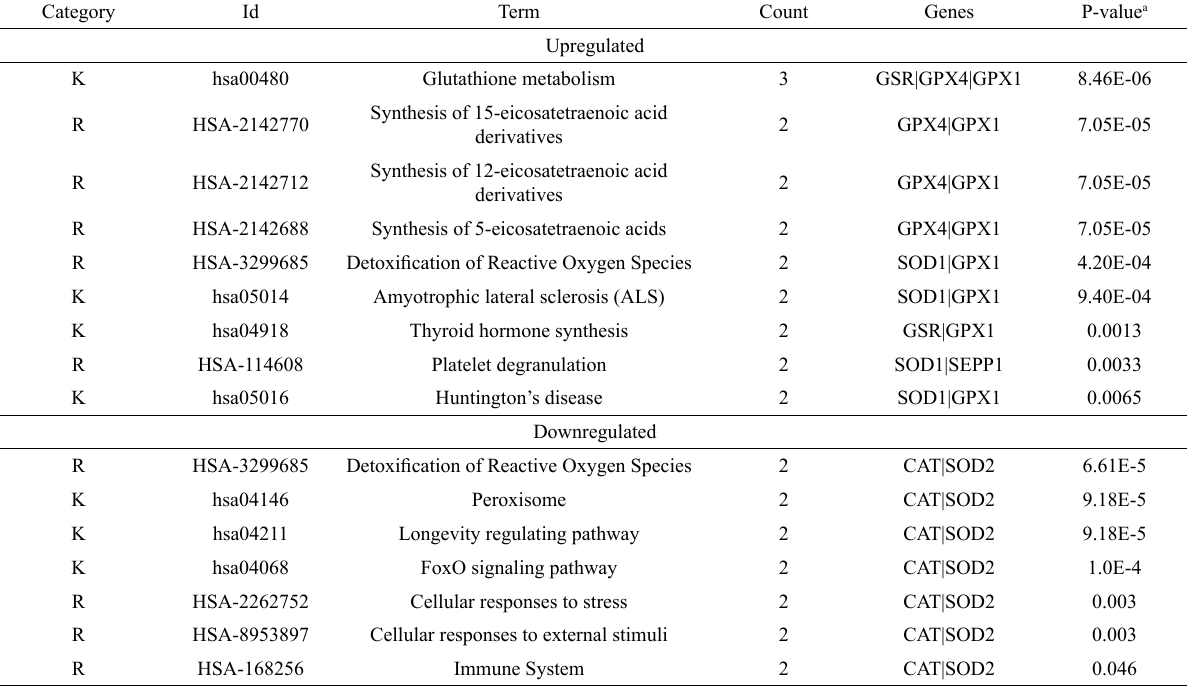
Table 4 – Top Most significant enriched